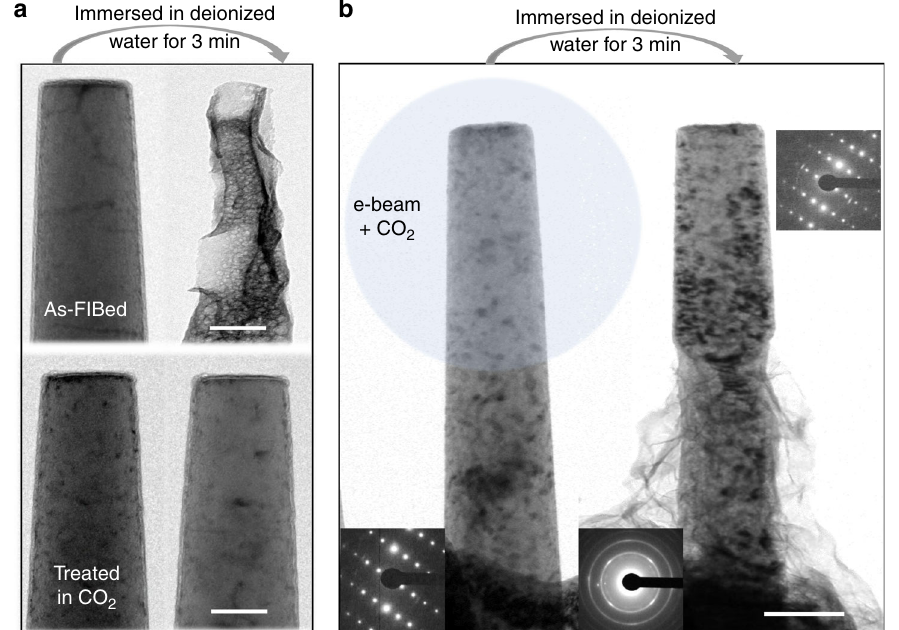
Fig. 3 Turning native Mg alloy surface into protective coating. a TEM images of two Mg pillars (as-FIBed Mg pillar and the pillar treated in CO 2 ) before and after immersion in deionized water for 3 min. b Only half of the ZK 60 Mg alloy pillar was irradiated by e-beam in CO 2 . The treated top half part was well protected from the aqueous environment and remained intact, as evidenced by the inset diffraction pattern, while the lower half was corroded seriously. Halos in the inset diffraction pattern indicate amorphous corrosion product. Scale bars: a 100 nm, b 200